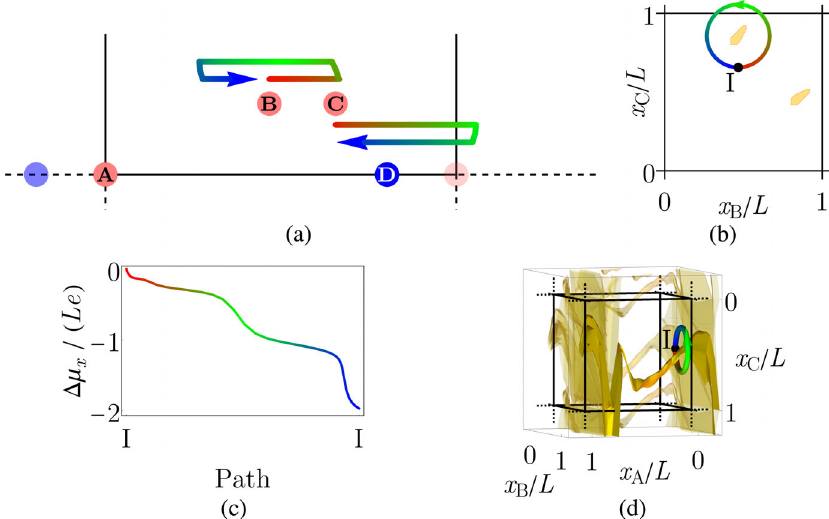
FIG. 3. A planar configuration of the K 3 Cl system undergoing a loop in atomic configuration space. (a) Initial and final configurations. K and Cl atoms are indicated by pink and blue circles, respectively. The colored curved arrows indicate the 1D trajectories of the two K atoms participating in the loop. The color encodes the fictitious time parametrizing the loop (red → blue). (b) Closed path in the 2D projection of the atomic configuration space relative to the atoms that participate in the loop; the yellowish areas indicate regions where the ground state is degenerate. (c) Dipole displaced along the closed path. (d) Closed path in the 3D projection of the ACS where also the x coordinate of atom A is shown. An animation illustrating the trajectory of the atoms participating in the loop can be found in the file S2.mp4 in Supplemental Material [18]. The green dots indicate the positions of the Wannier centers of the electrons in the